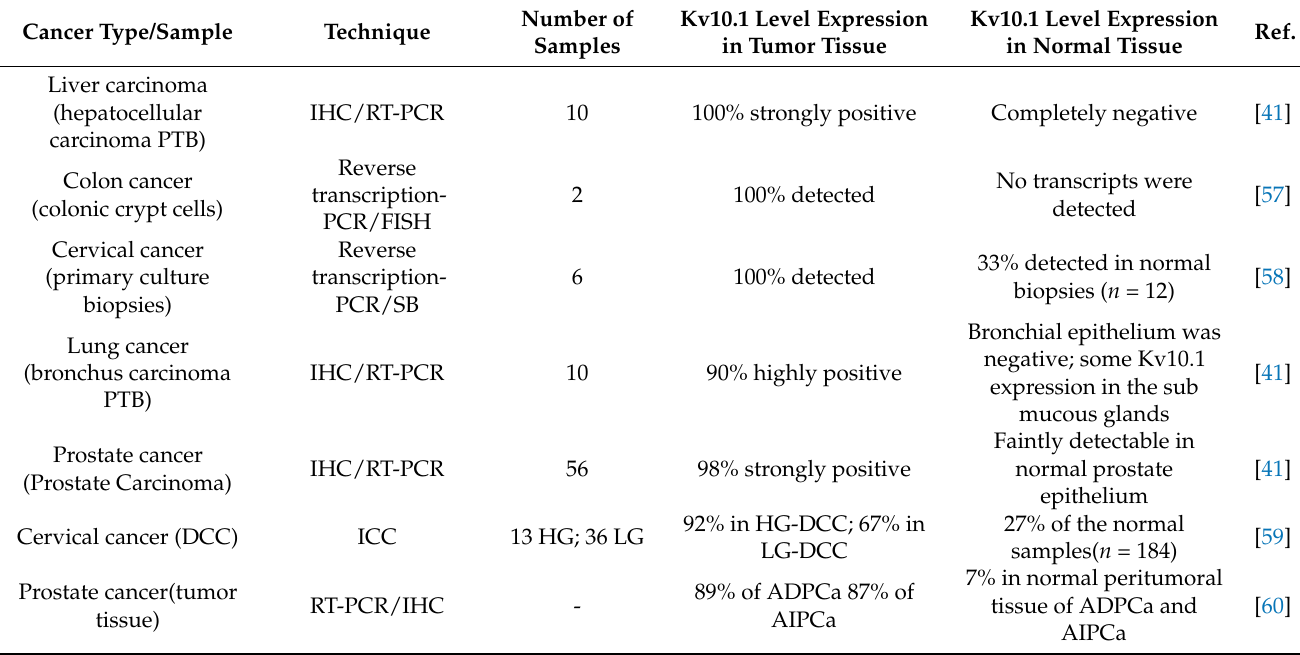
Figure 1. mRNA expression of KCNH1 across TCGA cancers in normal and tumor samples. Log of transcript per million (TPM) of KCNH1 mRNA from normal samples (blue box) and tumor samples (red box). The abscissa axis shows the number of samples and the type of tumor. The cancer genome atlas (TCGA), bladder urothelial carcinoma (BLCA), breast invasive carcinoma (BRCA), cervical squamous cell carcinoma (CESC), cholangiocarcinoma (CHOL), colon adenocarcinoma (COAD), esophageal carcinoma (ESCA), glioblastoma multiforme (GBM), head and neck squamous cell carcinoma (HNSC), kidney chromophobe (KICH), kidney renal clear cell carcinoma (KIRC), kidney renal papillary cell carcinoma (KIRP), liver hepatocellular carcinoma (LIHC), lung adenocarcinoma (LUAD), lung squamous cell carcinoma (LUSC), pancreatic adenocarcinoma (PAAD), prostate adenocarcinoma (PRAD), pheochromocytoma and paraganglioma (PCPG), rectum adenocarcinoma (READ), sarcoma (SARC), skin cutaneous melanoma (SKCM), thyroid carcinoma (THCA), thymoma (THYM), stomach adenocarcinoma (STAD), uterine corpus endometrial carcinoma (UCEC). * p < 0.05, ** p < 0.01, *** p < 0.0001. Data obtained from UALCAN (http://ualcan.path.uab.edu, accessed on 24 July 2022) [56]. Table 1. Kv10.1 expression in cancer .